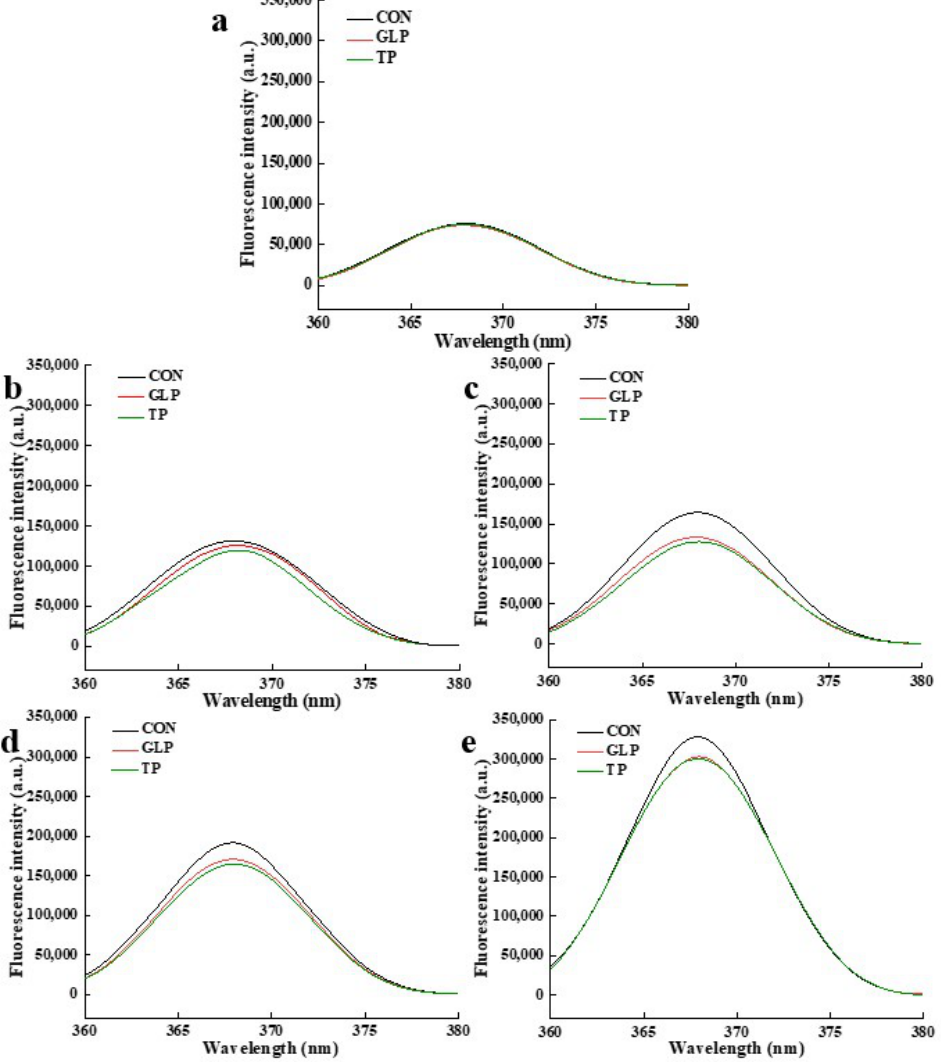
Figure 6. Effect of guava leaf polyphenols on the fluorescent AGEs content of frozen chicken meatballs. ( a – e ) indicate chicken meatballs are frozen for 0, 1, 2, 3, and 6 mon, respectively. GLP, guava leaf polyphenols; TP, tea polyphenol; CON, control.